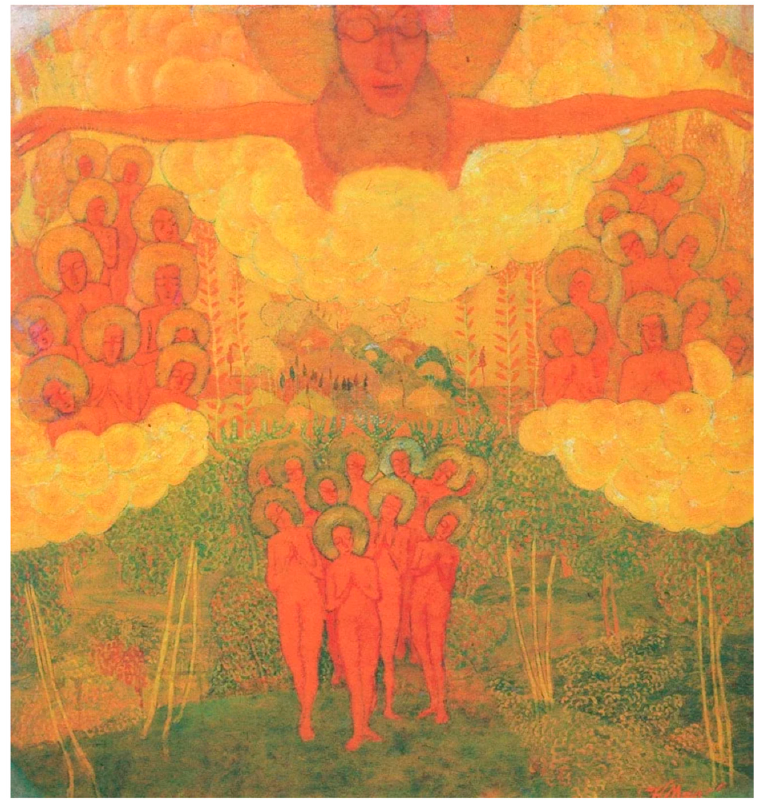
Figure 12. Kazimir Malevich. The Triumph of Heaven, 1907.